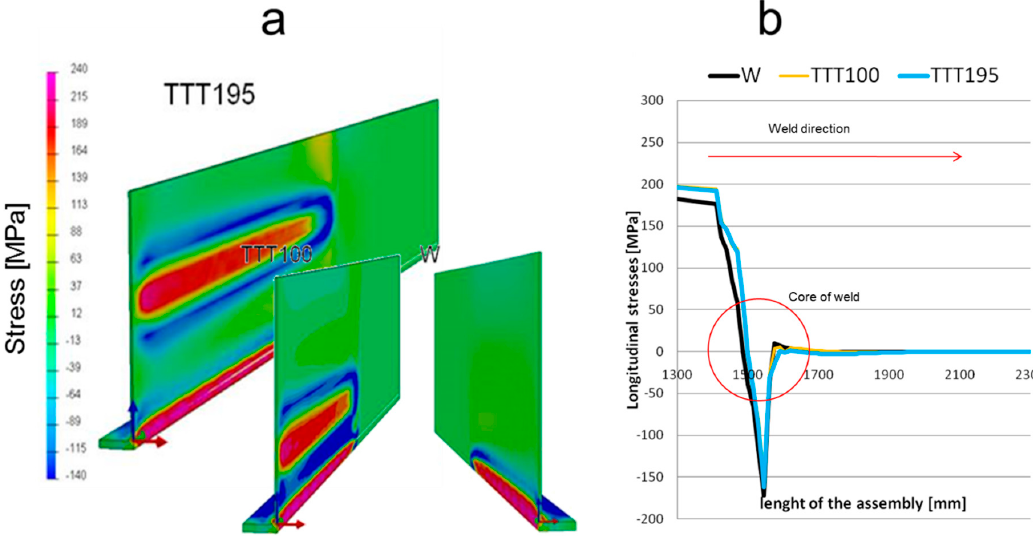
Figure 7. ( a ) Stresses distribution during the high-temperature TTT (htTTT) process (MPa); ( b ) stress distribution during the process.